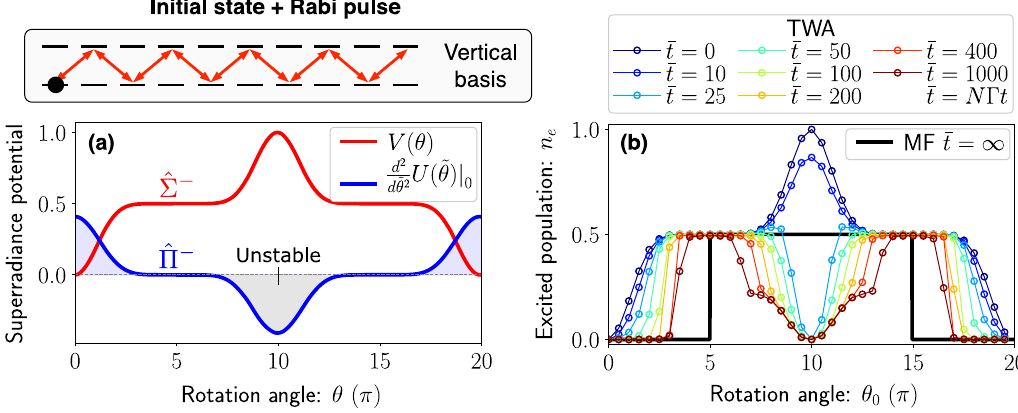
9 = 2 starting in the F g ¼ e ¼ ˆ Σ − decay and the P 1 =N Þ h ˆ σ q e i e ¼ ð m m e m